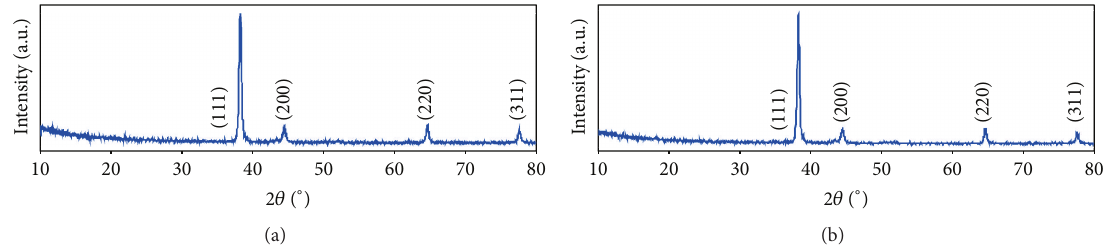
Figure 8: XRD patterns of Ag films electrodeposited by (a) high cyanide and (b) low cyanide silver solutions. The 𝑦 -axes of all panels are presented in the same